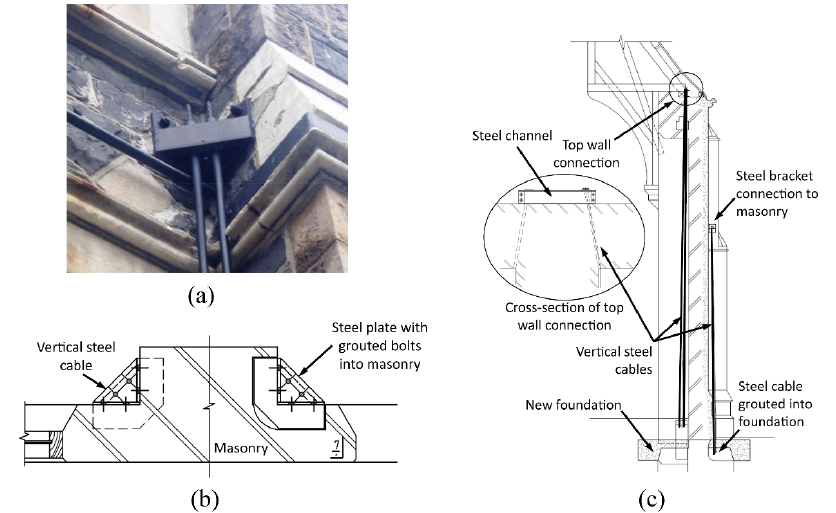
Figure 2. Detail of the anchorages for the external retrofitting intervention (from [43]): ( a ) real image of the external connection on the Chemistry building in Christchurch; ( b ) schematic representation of the detail in ( a ); ( c ) retrofit cross-section in the Great Hall of the Canterbury College with a detail of the bottom